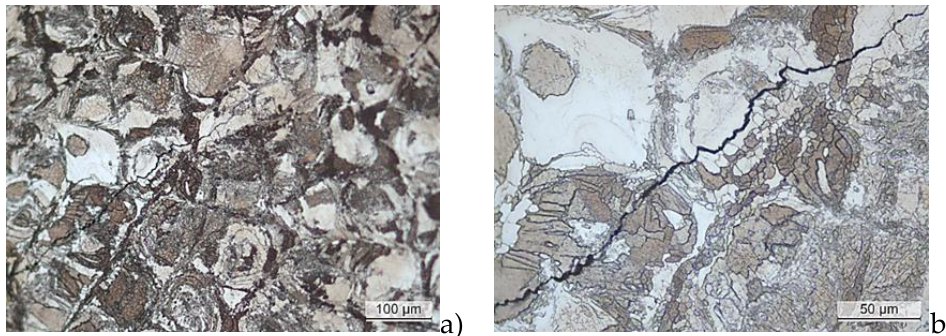
Figure 9. Comparison between the crack path and the microstructure. ( a ) 100 µ m, ( b ) 50 µ m. The chemical composition of the melt pools was investigated by Energy-Dispersive X-ray Spectroscopy (EDS) analysis as reported in Figure 10 and Table 4. No appreciable difference was detected among the pool center and